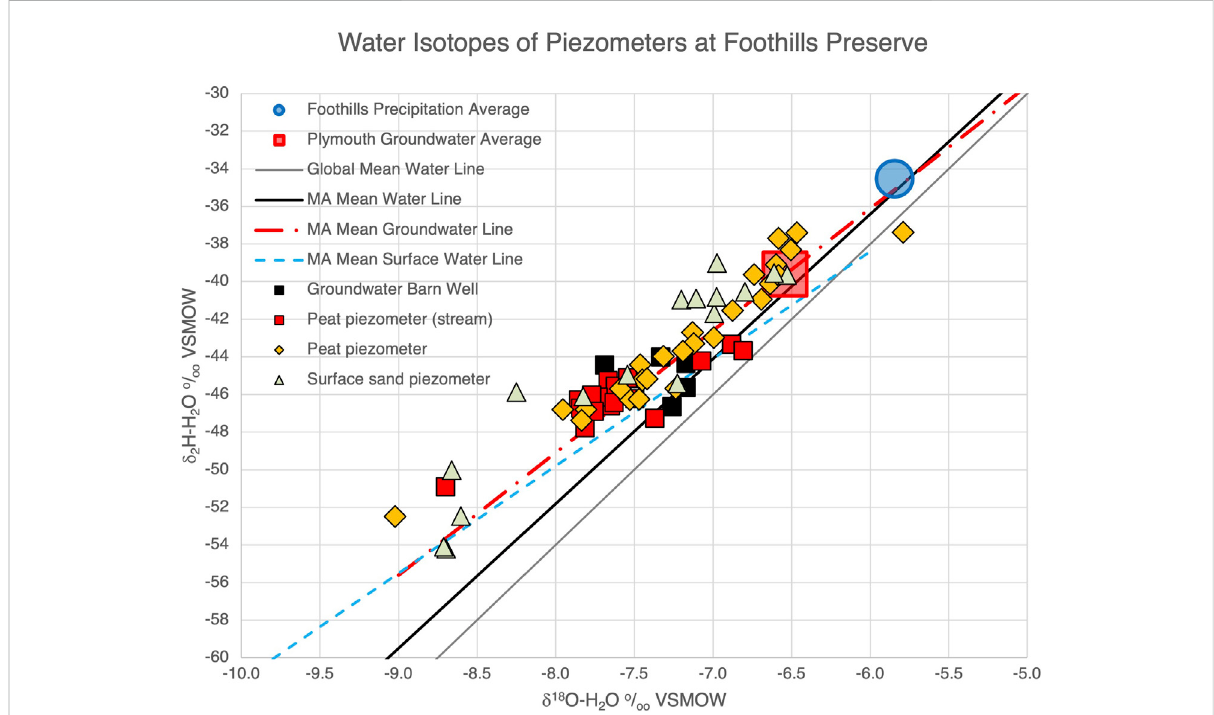
FIGURE 10 Isotopic compositionofFoothills Preserve waters collectedfrom piezometers andwells. Trendlinesshowninclude theGlobalMean WaterLine (GMWL, thin grey), the Massachusetts MWL (MA MWL, thick black) the Massachusetts Surface Water Line (MA SWL, simple dash, cyan), and the MassachusettsGroundwaterLine(MAGWL,dot-dash,red);andaveragegroundwaterfromthePlymoutharea(largeredsquare)fromColeandBoutt (2021). Symbology of sample sources include: Average Foothills Preserve precipitation (large blue circle), peat piezometer samples installed in the streambed (red squares), peat piezometer samples installed on the bog surface (yellow diamonds), sand aquifer piezometers (green triangles), and the Barn groundwater well (black